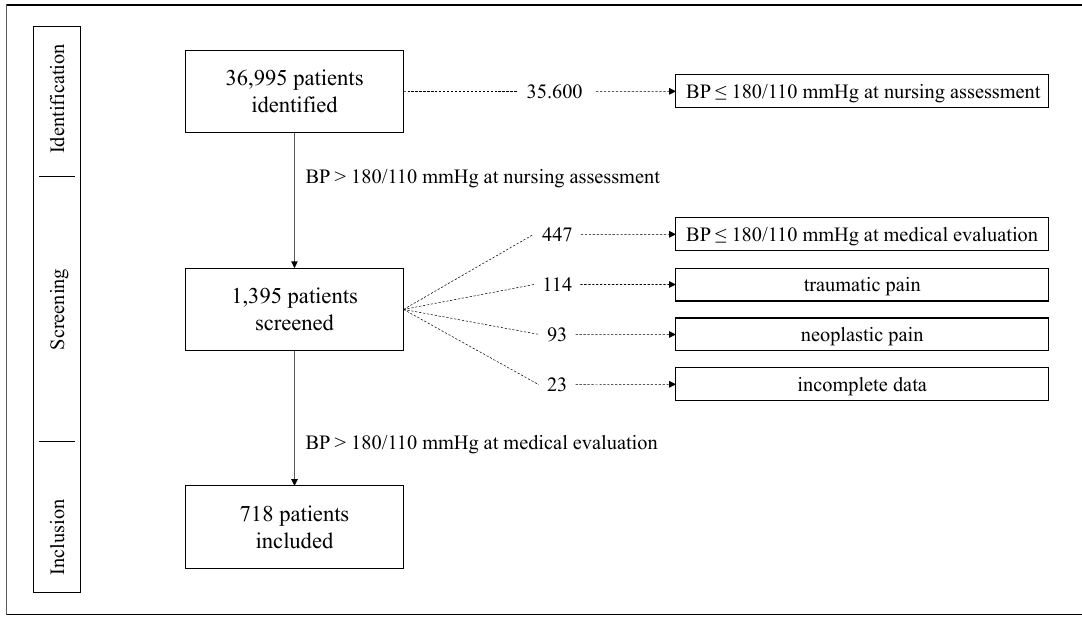
Figure 1. Flowchart of patient selection process. BP: blood pressure. Table 1. Demographic and clinical characteristics.